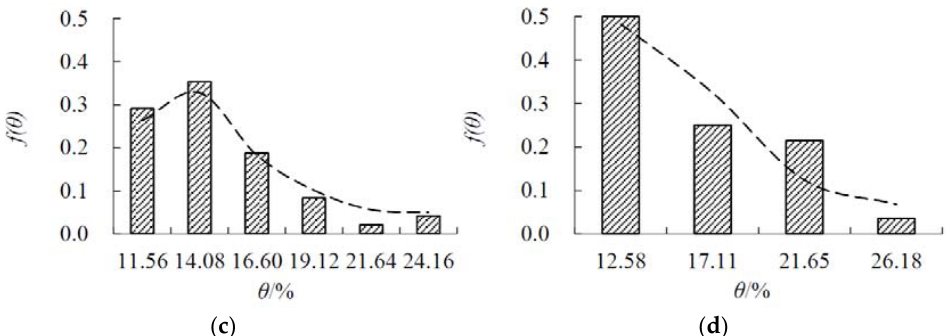
Figure 13. Probability distribution of the observed and simulated θ at different sampling intervals. ( a ) 10-day sampling interval in the calibration period; ( b ) 10-day sampling interval in the validation period; ( c ) 30-day sampling interval in the calibration period; ( d ) 30-day sampling interval in the